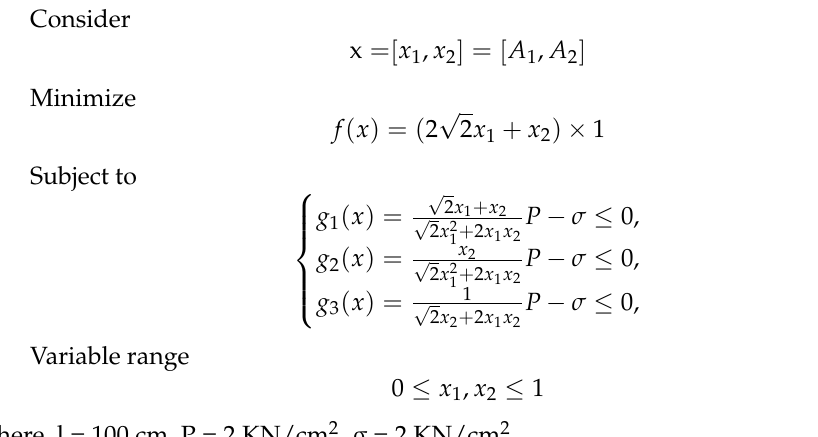
Figure 9. Three-bar truss design